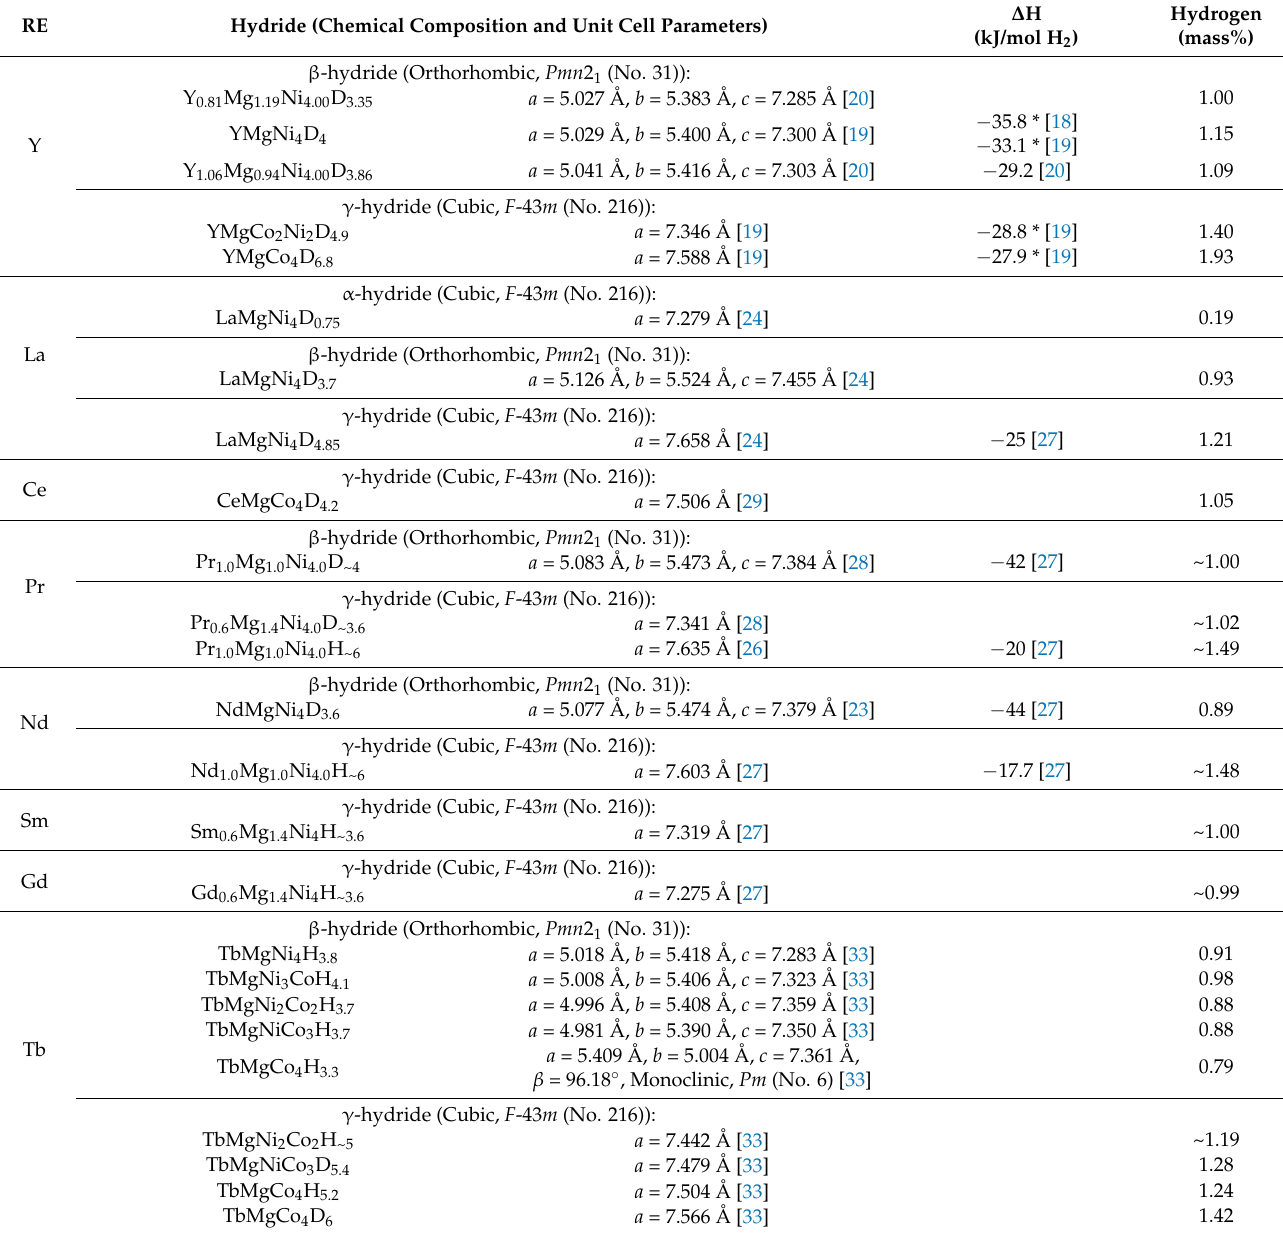
Table 1. The experimentally reported hydride phases of REMgNi 4 -based alloys with unit cell parameters, formation enthalpy of the hydride ∆ H, and hydrogen contents (an asterisk indicates enthalpy of the hydride, which was obtained from the hydrogen release